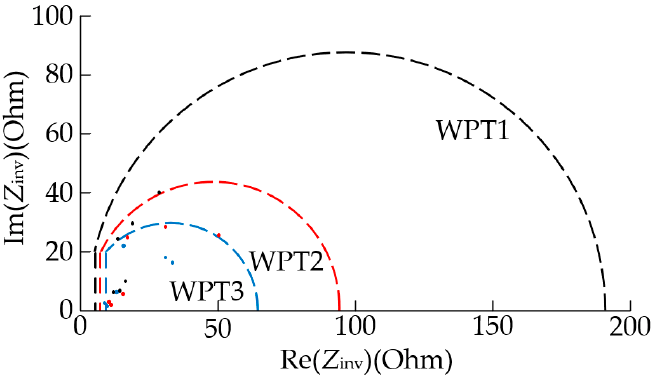
Figure 14. Reference region of inverter port impedance proposed by Tsinghua University.